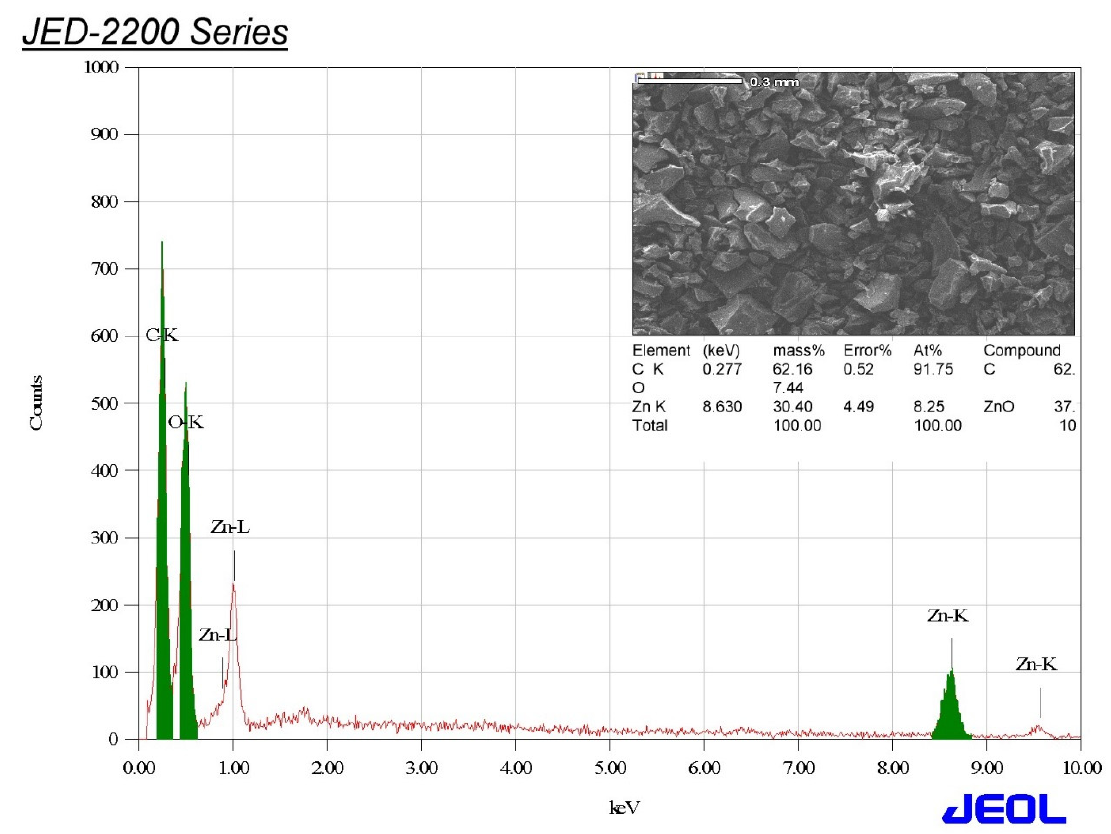
Figure 6. EDX analysis and SEM micrograph of the green synthesized zinc oxide nanoparticles .